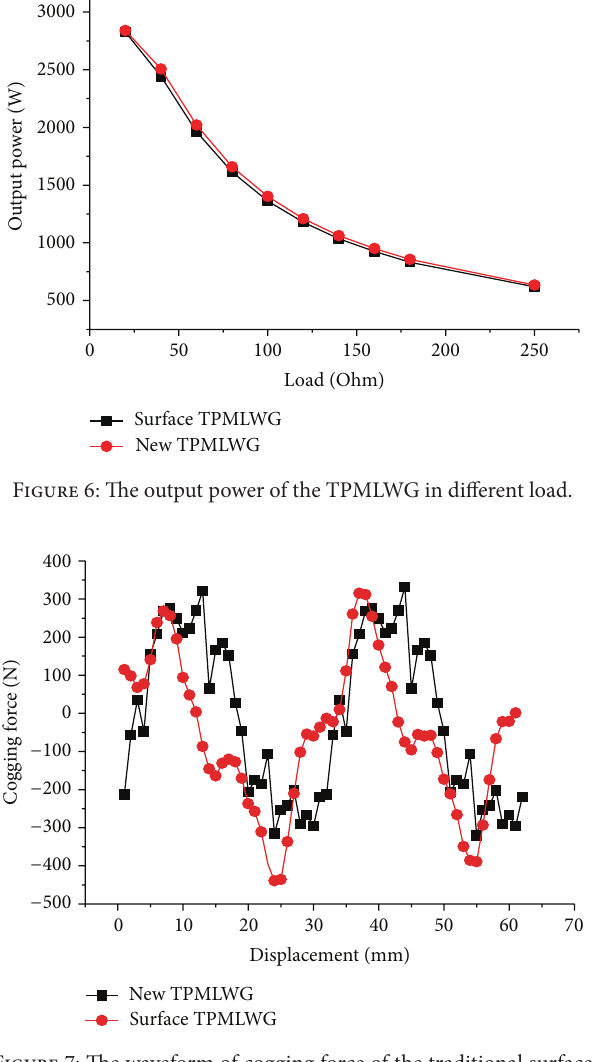
Figure 7: The waveform of cogging force of the traditional surface TPMLWG and the new secondary structure TPMLWG.